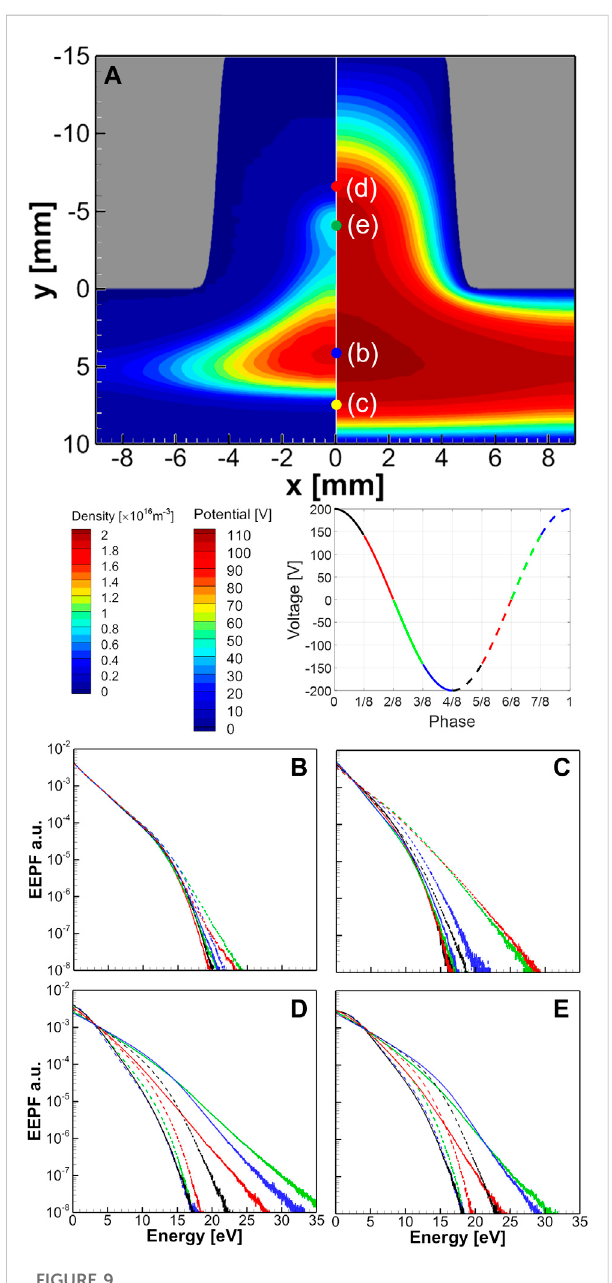
FIGURE 9 (A) The time-averaged spatial pro fi les ofthe electron density (left side) and electrical potential (right side) for the same conditions as the case of Figure 8B. The phase-resolved electron energy probability functions are calculated at the locations at (B) the density peak position in the bulk plasma, (C) the bottom sheath, (D) the top sheath, and (E) the density peak point in the hole. The phase-resolved plot shows four sheath-expanding (solid) and sheath-shrinking (dotted) phases in blue, yellow, red, and green colors for the applied voltage phase shown in the second row. border of EERL to be the same as the gap distance, 15 mm. With a hole length of 6 mm, most EERL is less than 5 mm near the electron heating regions, and thus two density peaks at y = 1 mm and y = 6 mm are generated, as shown in Figure 3D.